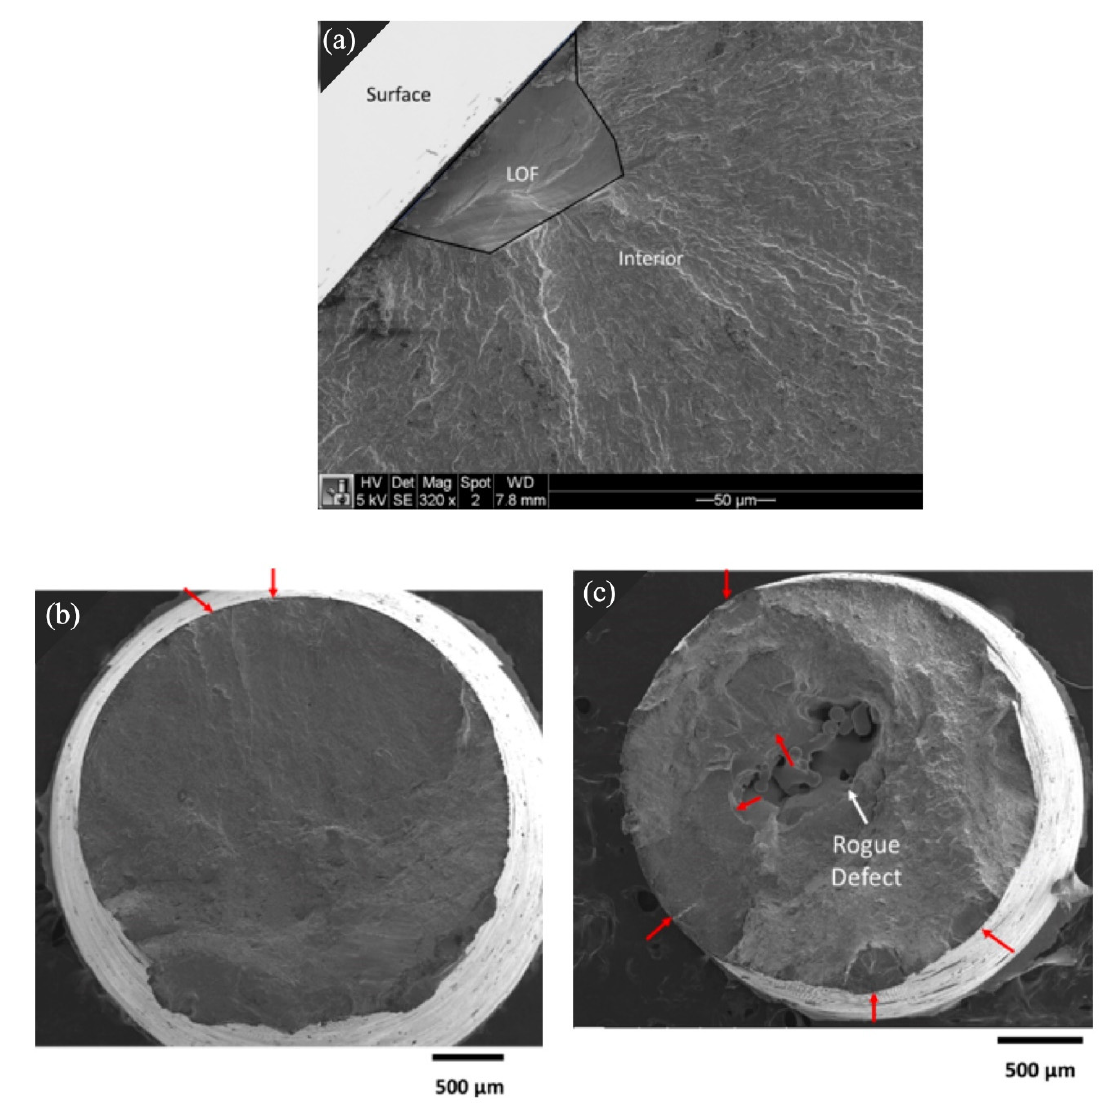
Figure 11. SEM fractographs of ( a ) LOF defect that was exposed to the surface after machining, ( b ) low porosity sample exhibiting two dominant origins at the surface, both exposed LOF defects, and ( c ) multiple surface origins in a specimen with large rogue defect at the center. Both ( b , c ) are from machined 3 ‐ mm thickness specimens.